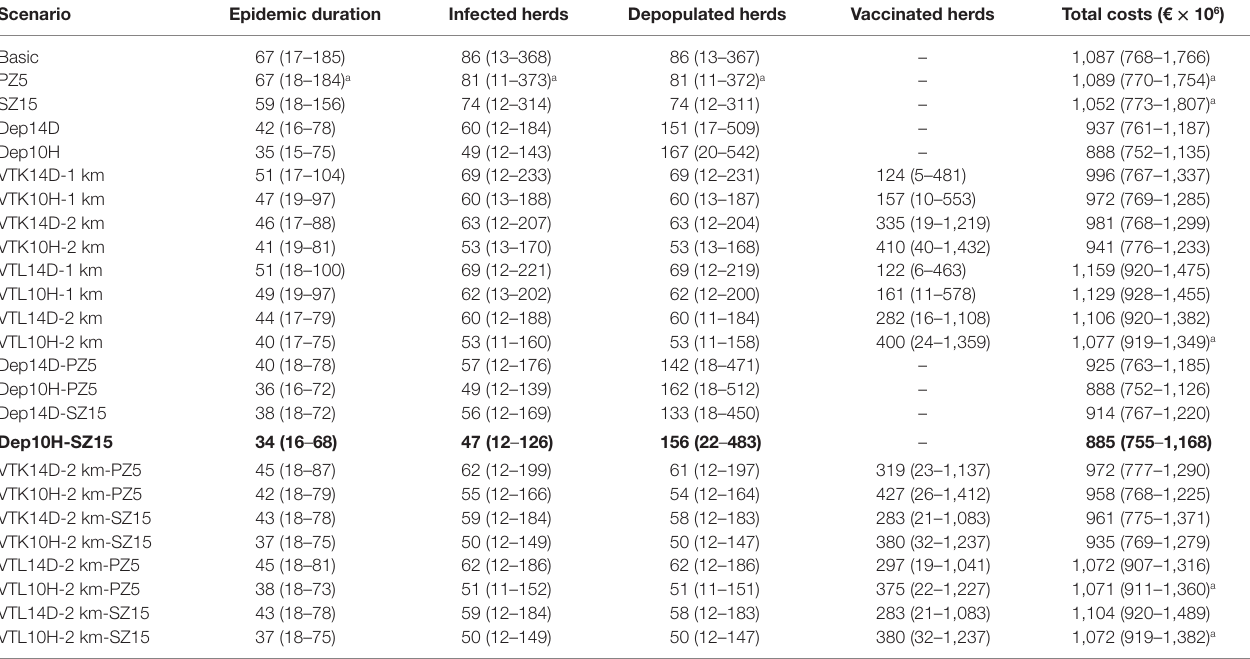
TaBle 1 | epidemiological and economic consequences of simulated FMD epidemics in Denmark under different control scenarios, when epidemics were initiated cattle